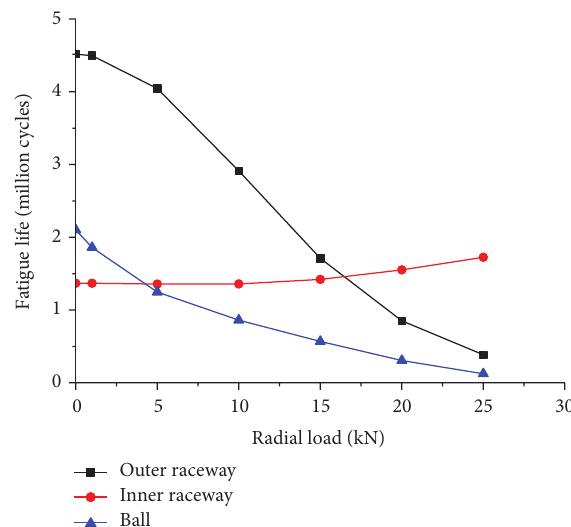
Figure 8: The change of fatigue life with radial load 𝐹 𝑟 .